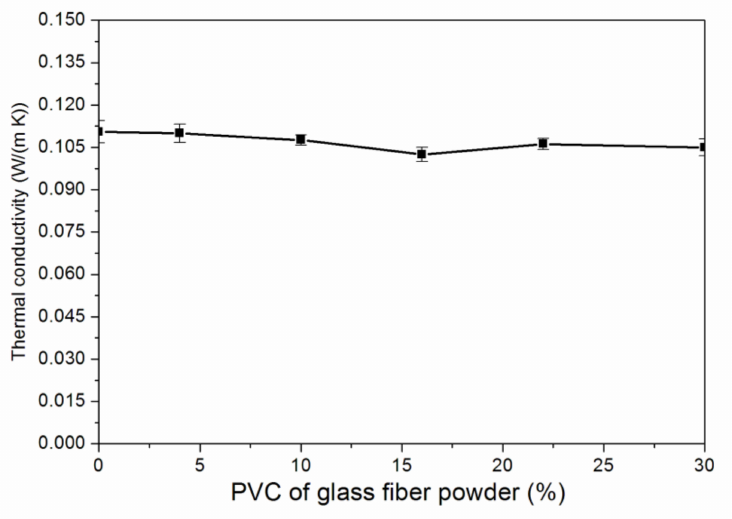
Figure 3. Thermal conductivity of the coated assembly with di ff erent PVC of glass fiber